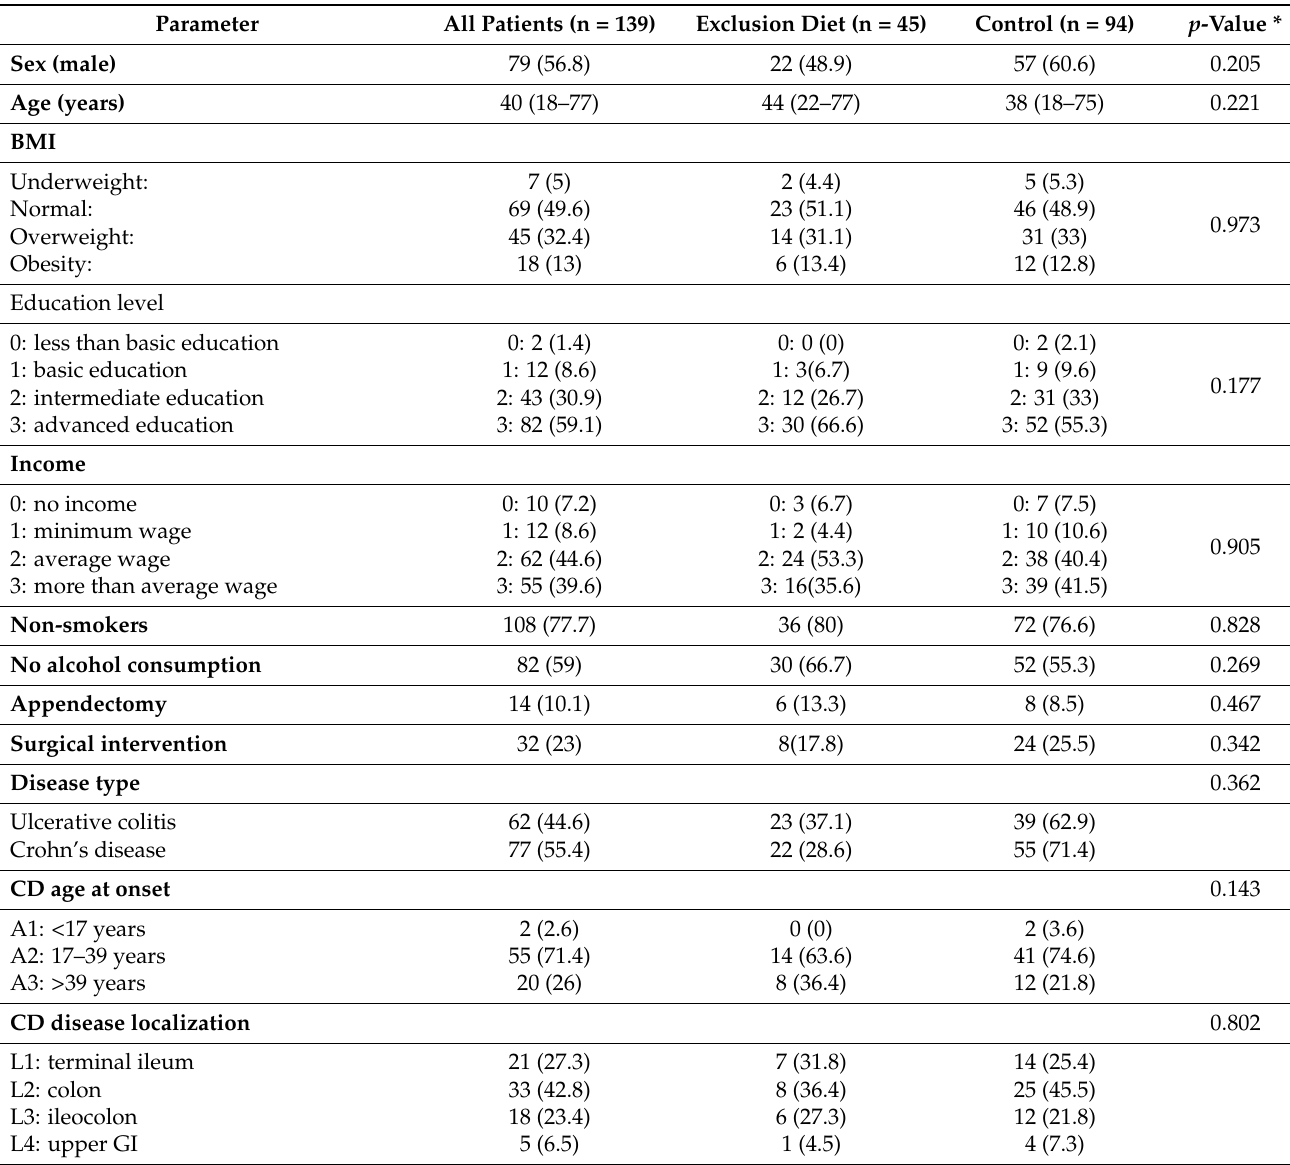
Table 2. Baseline patient